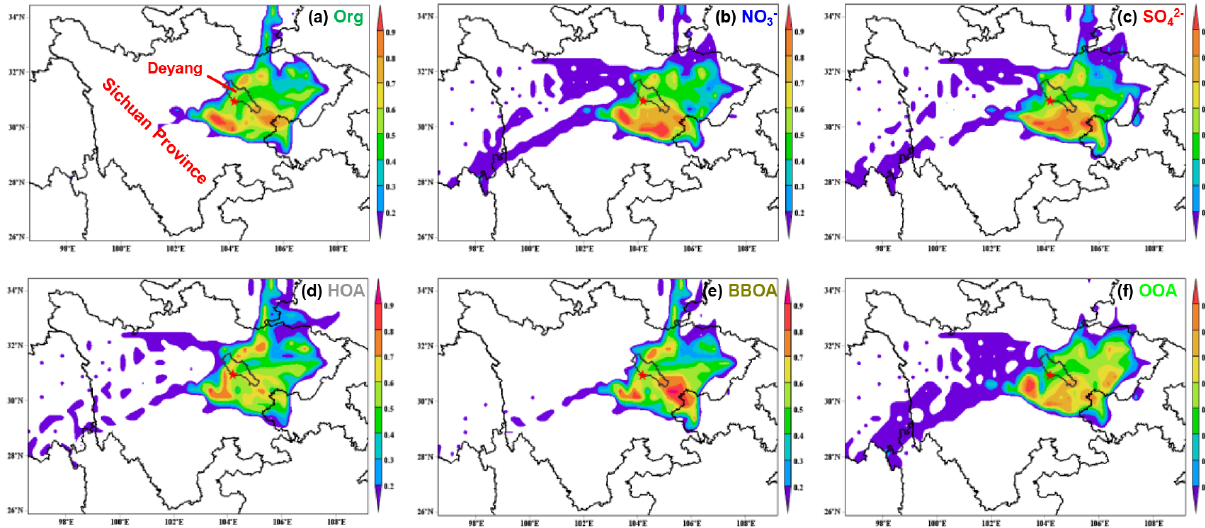
Figure 10. Simulation results of PSCF for (a) organics, (b) nitrate, (c) sulfate, (d) HOA, (e) BBOA and (f) OOA during the whole campaign. The 50th percentiles of the concentrations for each composition (organics: 39.5µgm − 3 , nitrate: 27.8µgm − 3 , sulfate: 9.5µgm − 3 , HOA: 7.6µgm − 3 , BBOA: 8.7µgm − 3 , OOA: 15.2µgm − 3 ) were used as thresholds in the PSCF analysis. The areas of Deyang and Sichuan Province are marked in (a) .